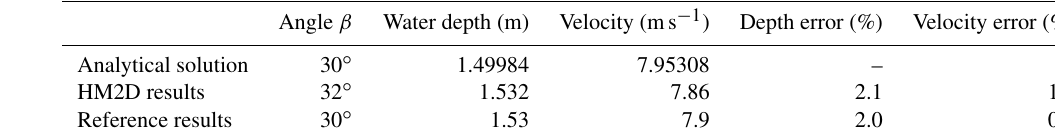
Table 1. Comparison between the analytical solution and calculation result for the oblique jump case.